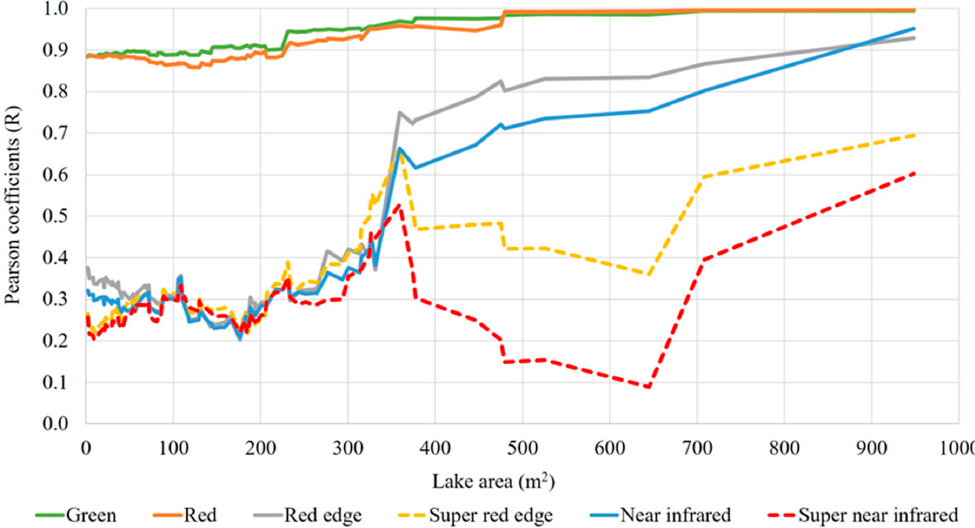
Figure 11. Variation of the Pearson correlation coefficient (R) with a moving threshold of water body area in KWAK for Sentinel-2 imagery and Parrot Sequoia reflectance measurements.